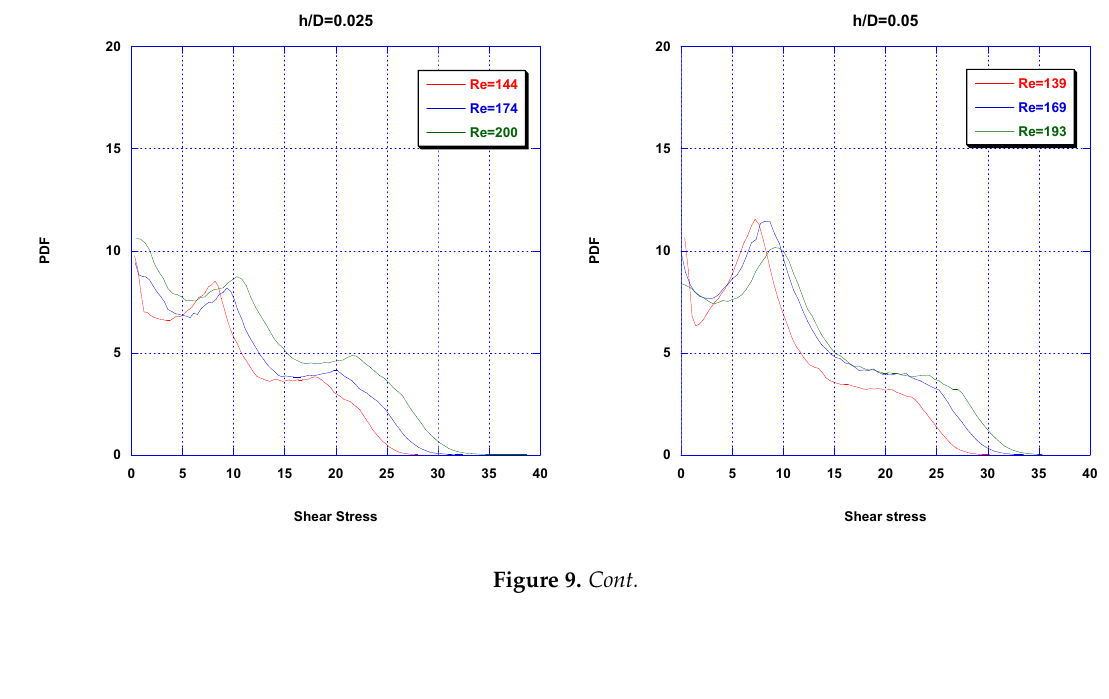
Figure 8. Percent probability density function of the dimensionless local time-averaged shear stresses on the membrane surface for the cases examined in this work. Re ~ 135. Shear stresses are normalized with the quantity μ U / D .